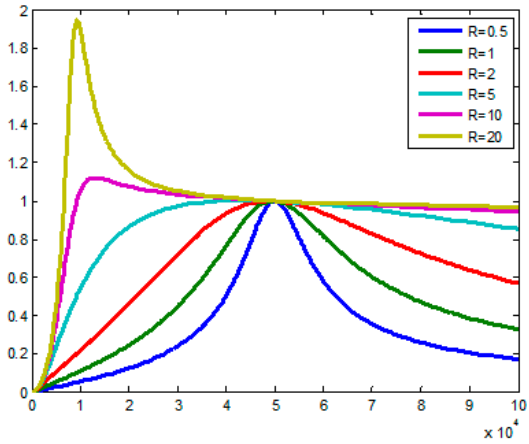
Figure 12. Voltage gain characteristics of LLC resonant converter s.